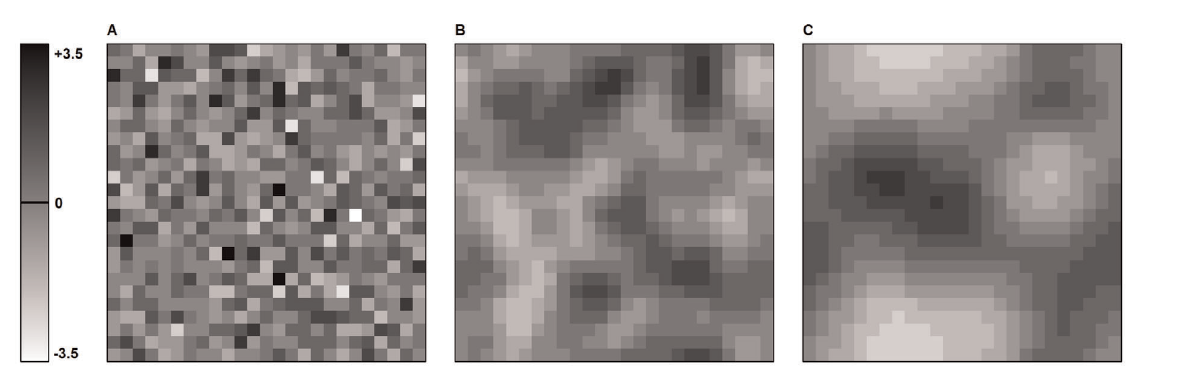
Figure 1. Environmental spatial structure for three degrees of spatial autocorrelation a . (a) a =0. (b) a =5. (c) a =10. The landscape size is 25 cells by 25 cells. Dark cells represent high environmental values E i and light cells low values.